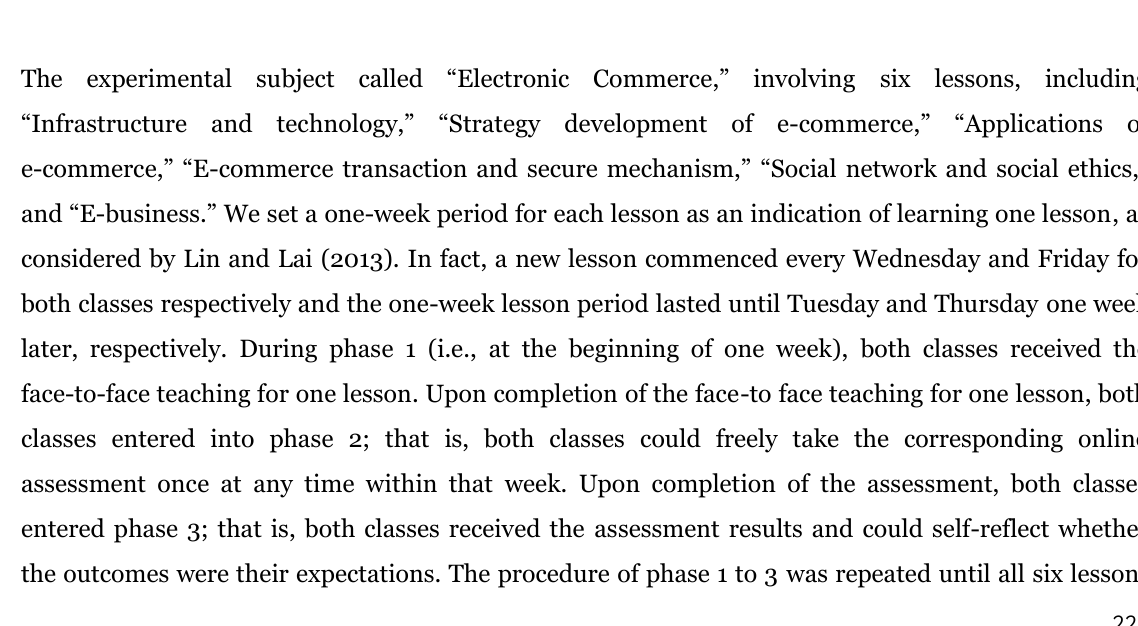
Figure 1. The experiment